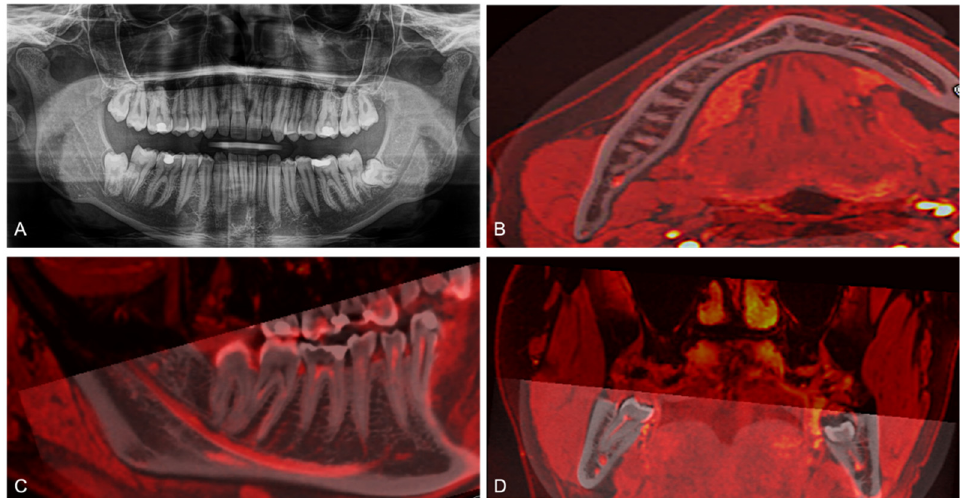
Figure 4. ( A ) Two ‐ dimensional panoramic radiography (PAN) of a study participant, CBCT and MRI scans of a study participant were transferred to OnDemand3D and fused using the “automatic registration” function at an equal slice thickness of 0.5 mm. The MRI scan was labeled red, and conventional grayscale values displayed the CBCT scan. Axial ( B ), sagittal ( C ), and coronal ( D ) fused CBCT/MRI images are visualized.